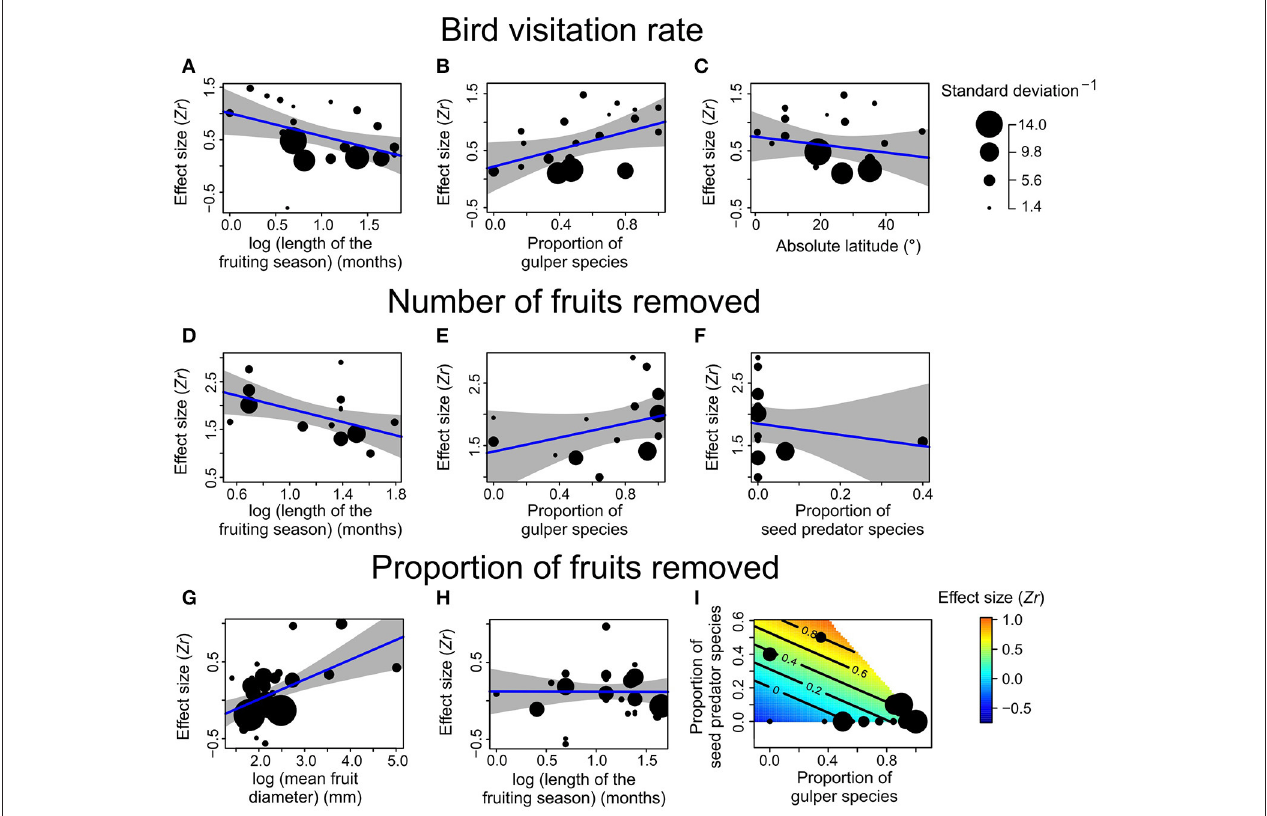
FIGURE 2 | Effect sizes for factors explaining variation of bird-mediated selection on fruit crop size for three fitness components: (A–C) visitation rate, (D–F) number of fruit removed, and (G–I) proportion of fruit removed. (A–H) show simple meta-regression models (blue lines) and 95% confidence intervals (shaded areas), whereas (I) shows a response surface between the proportion of gulper species, the proportion of seed predator species (explanatory variables) and the effect size as response variable (contour lines and scale bar). The length of the fruiting season and mean fruit diameter represent a plant trait, the proportion of gulper and seed predator species represent bird assemblage traits, and latitude represents environmental